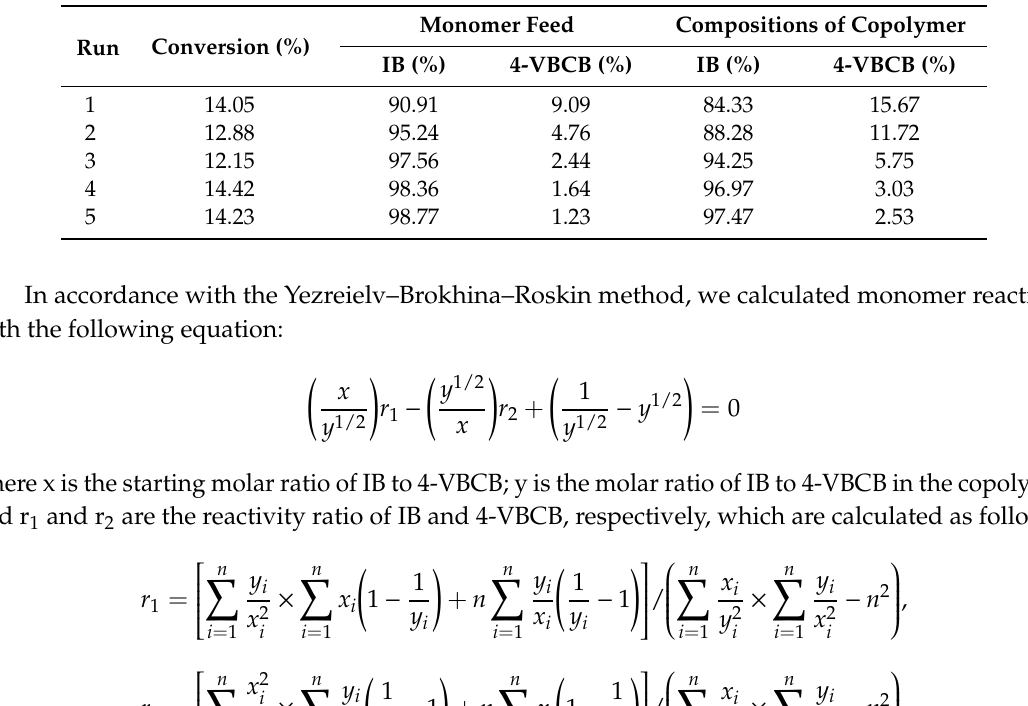
Table 1. IB and 4-VBCB contents in the copolymer calculated by 1 H NMR.